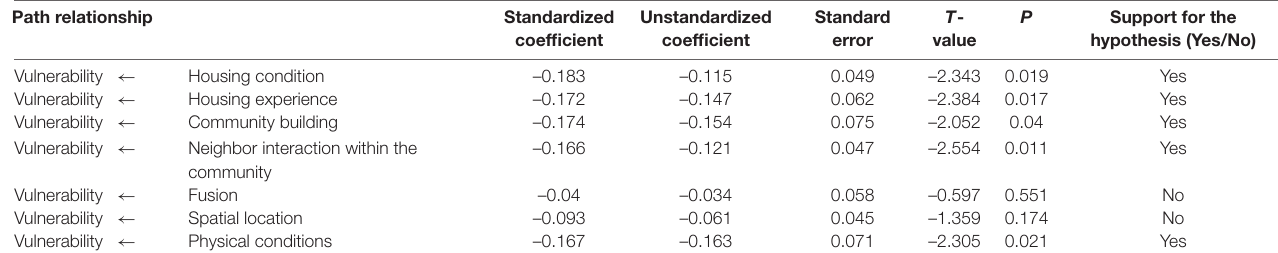
TABLE 7 | Path analysis